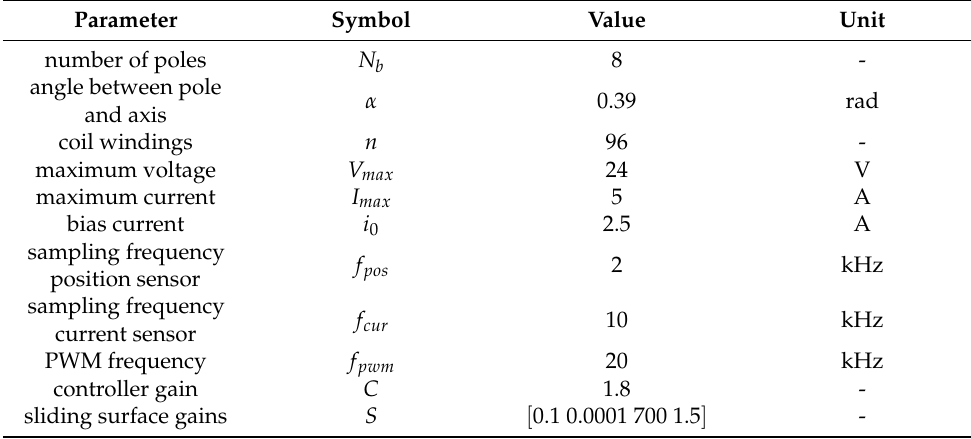
Table A3. Test bench and controller